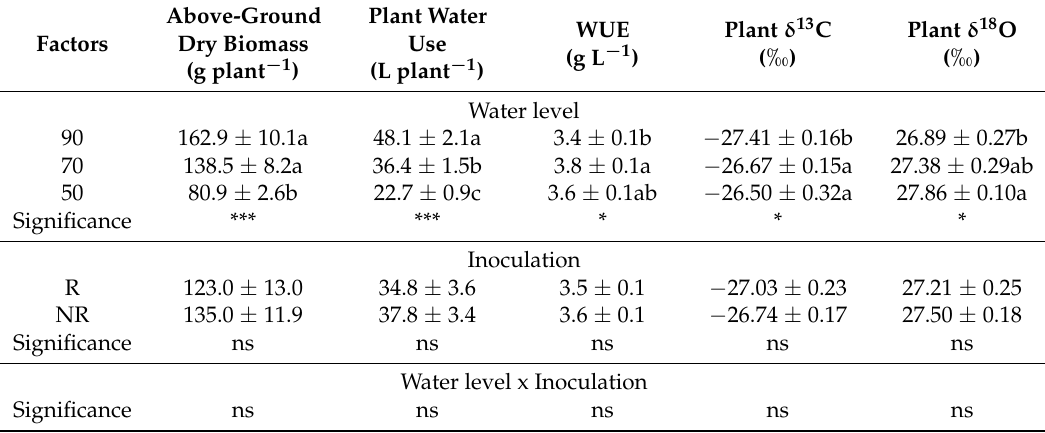
Table 1. Effect of soil water regimes, rhizobia inoculation and their interactions on biomass accumulation, plant water use, water use efficiency (WUE), plant carbon and oxygen isotopic compositions ( δ 13 C and δ 18 O) of cowpea under different soil water regimes (90%, 70%, and 50% of soil water holding capacity (SWHC)) and rhizobia inoculation. Values are means ± SE (n = 8 for 90%, 70%, and 50% of SWHC treatments and n = 12 for inoculated and non- inoculated (R and NR) treatments). Means with different letters indicate significant differences and ns denotes not significant at p < 0.05 according to Duncan’s multiple range